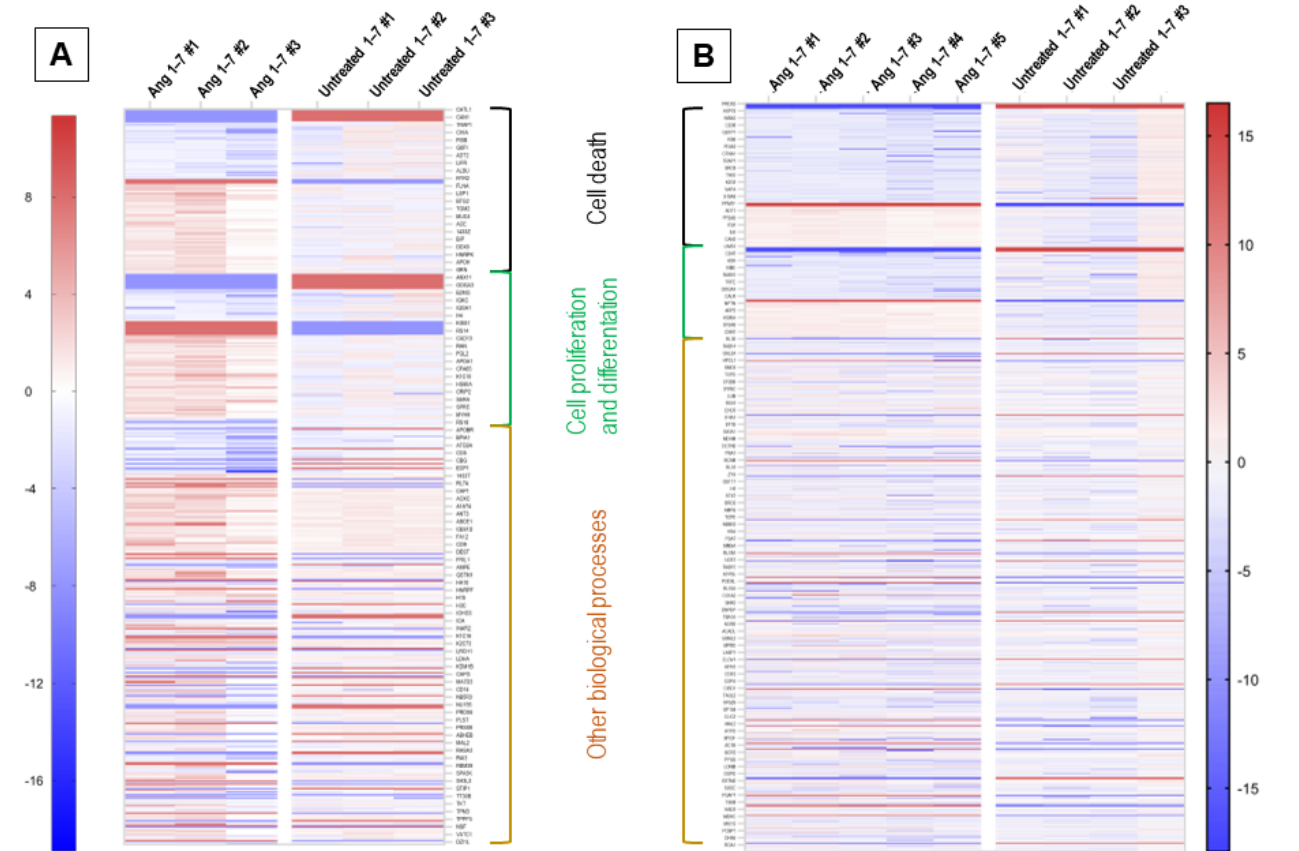
Figure 5. Heat map representing proteome expression changes analysis of identified proteins. Colors correspond to fold change of protein expression. Regions with certain biological processes are labeled in which represented genes are involved. Panel ( A ): BAL fluid protein profile expression changes after Ang (1–7) stimulation in comparison to BAL fluid isolated from untreated mice. Panel ( B ): Proteome expression observed in whole lung tissue lysate isolated from angiotensin (1–7) and untreated mice.